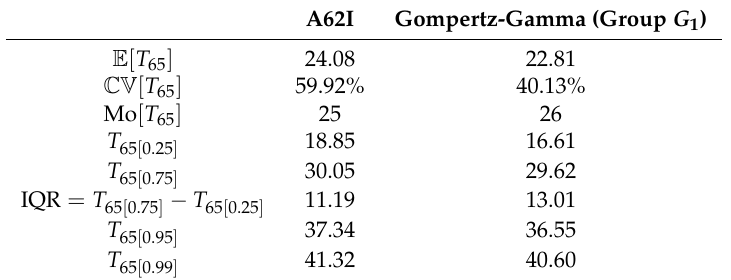
Figure 3. Comparison between the life table A62I and the Gompertz-Gamma model for group G 1 (force of mortality, probability density function of T 65 , survival function). ( a ) Force of mortality µ x ; ( b ) Prob. density function f 65 ( t ) ; ( c ) survival function S ( x ) . Table 4. Summary statistics of the probability distribution of the lifetime T 65 . Risk group G 1